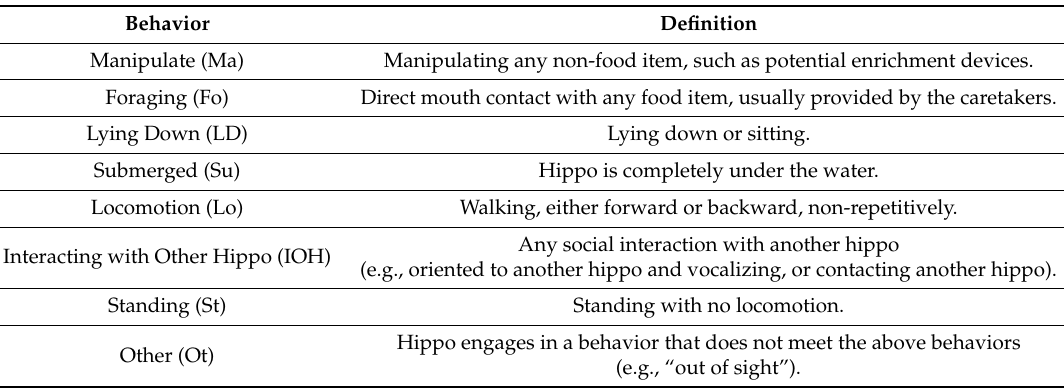
Table 1. Behaviors and definitions for each response categorized in the